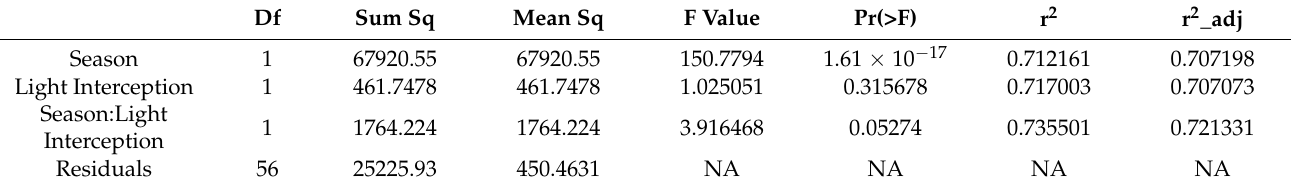
Table A14. Compression